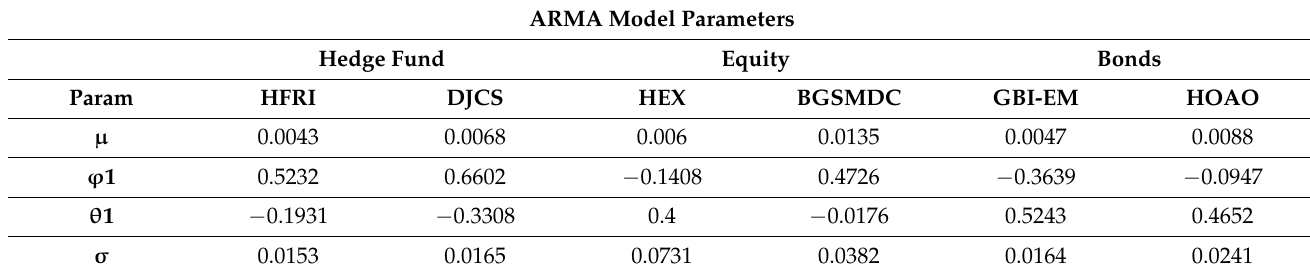
Table 4. ARMA parameters. Source: